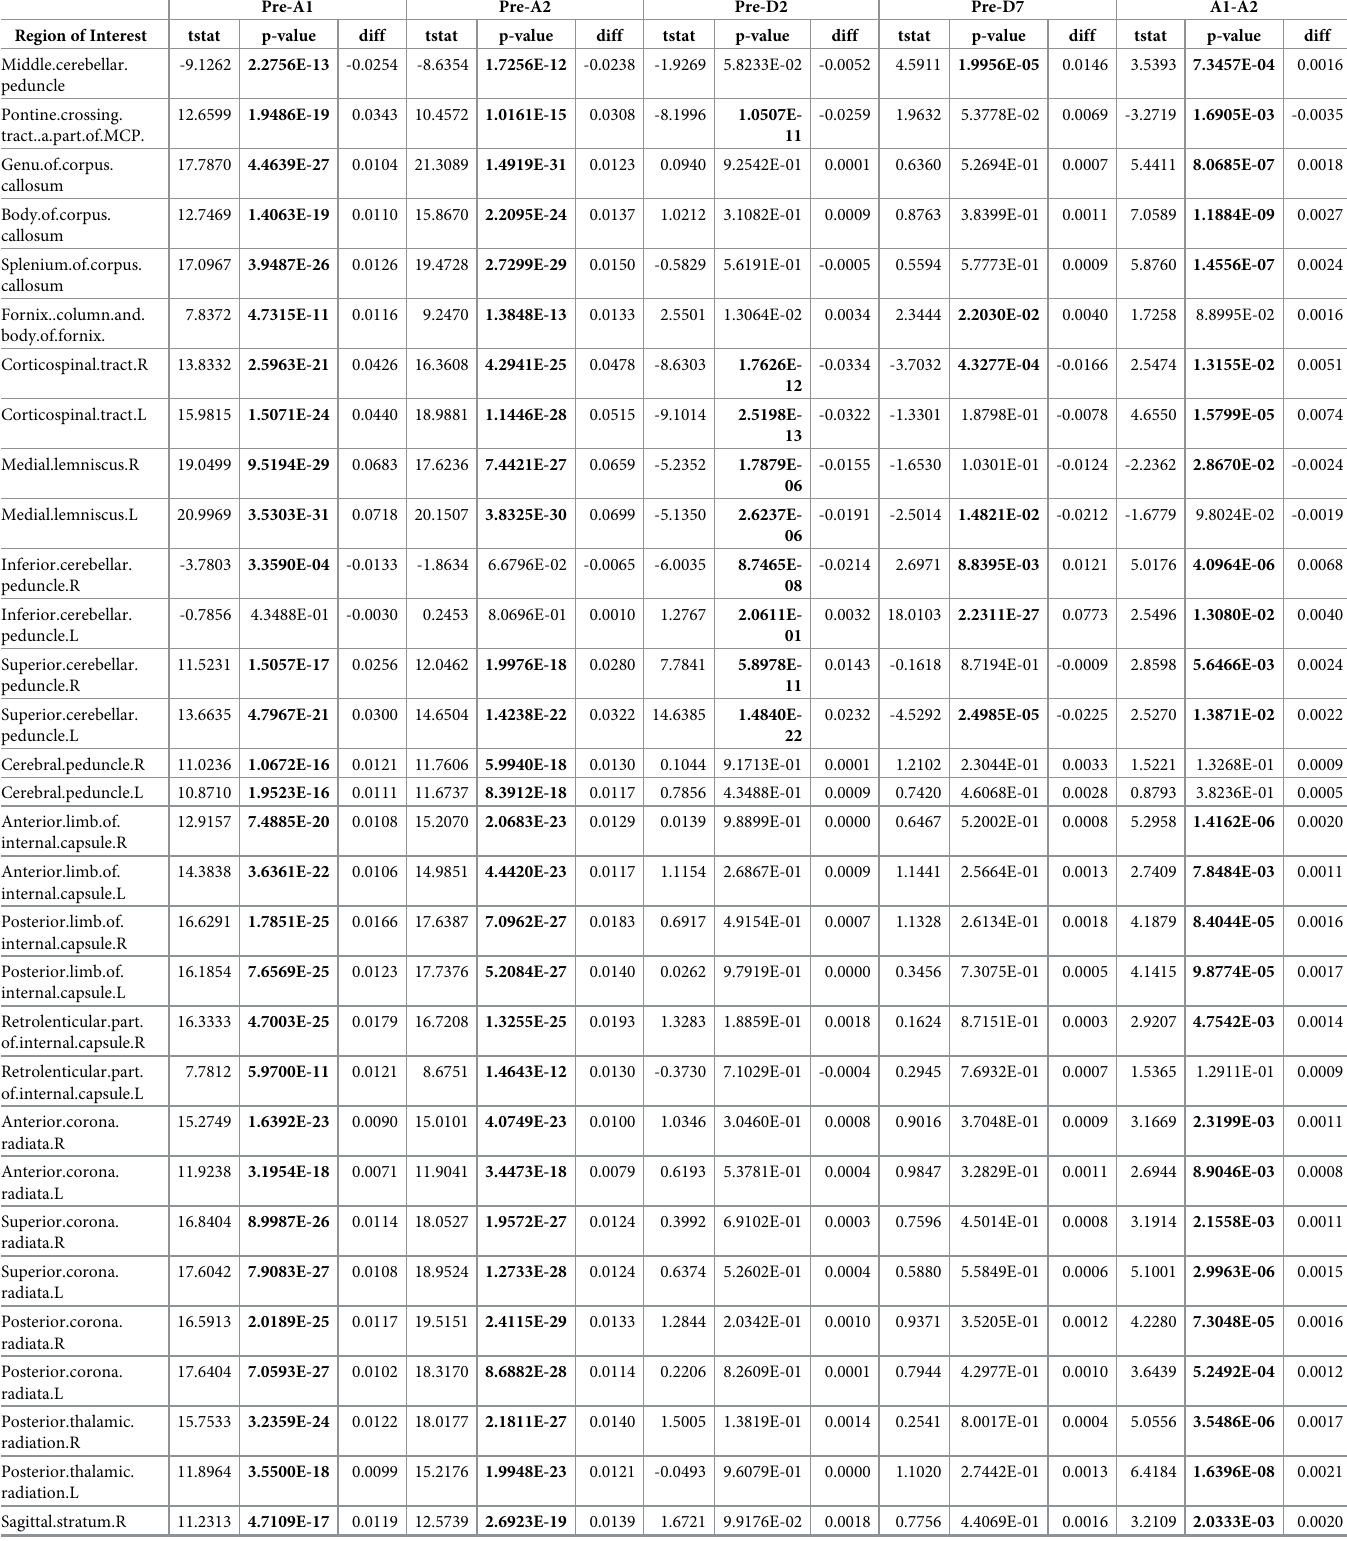
Table 4. Statistical comparisons of the 48 white matter ROIs by the Johns Hopkins Atlas for the different time point pairs. Pre-A1 Pre-A2 Pre-D2 Pre-D7 A1-A2 Region of Interest tstat p-value diff tstat p-value diff tstat p-value diff tstat p-value diff tstat p-value